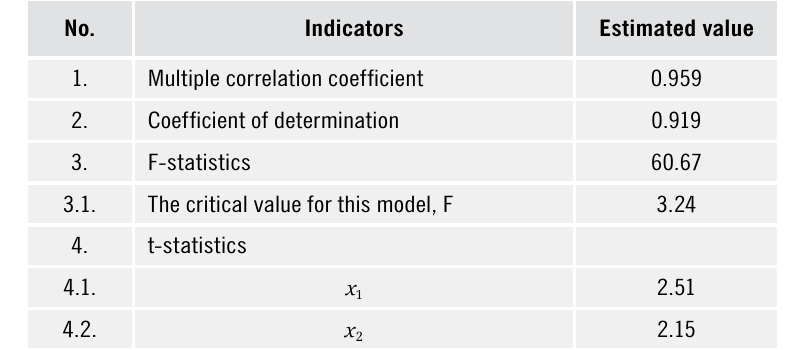
Table 3. Results of checking the adequacy of the economic-mathematical model on the main statistical